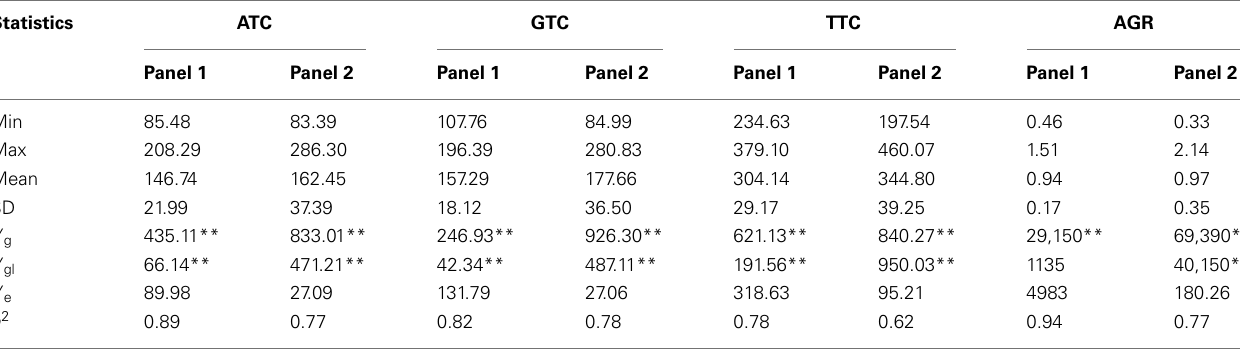
Table 1 | Ranges, means,ANOVA statistics (components of variance of genotype, genotype × environment interaction, and residual error),